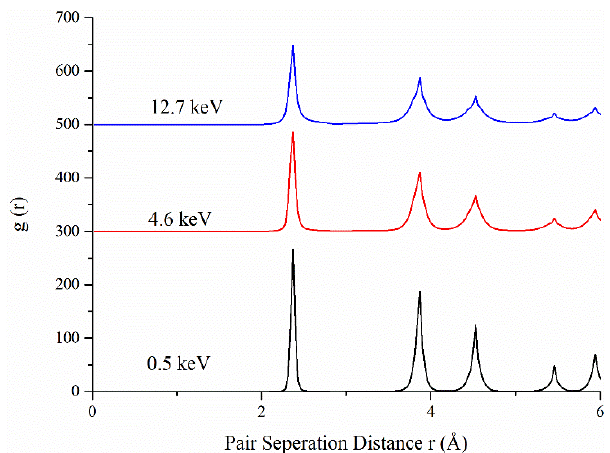
Figure 3. Radial distribution function of the silicon target during 0.5 keV, 4.6 keV, and 12.7 keV Si 35 cluster implantation.